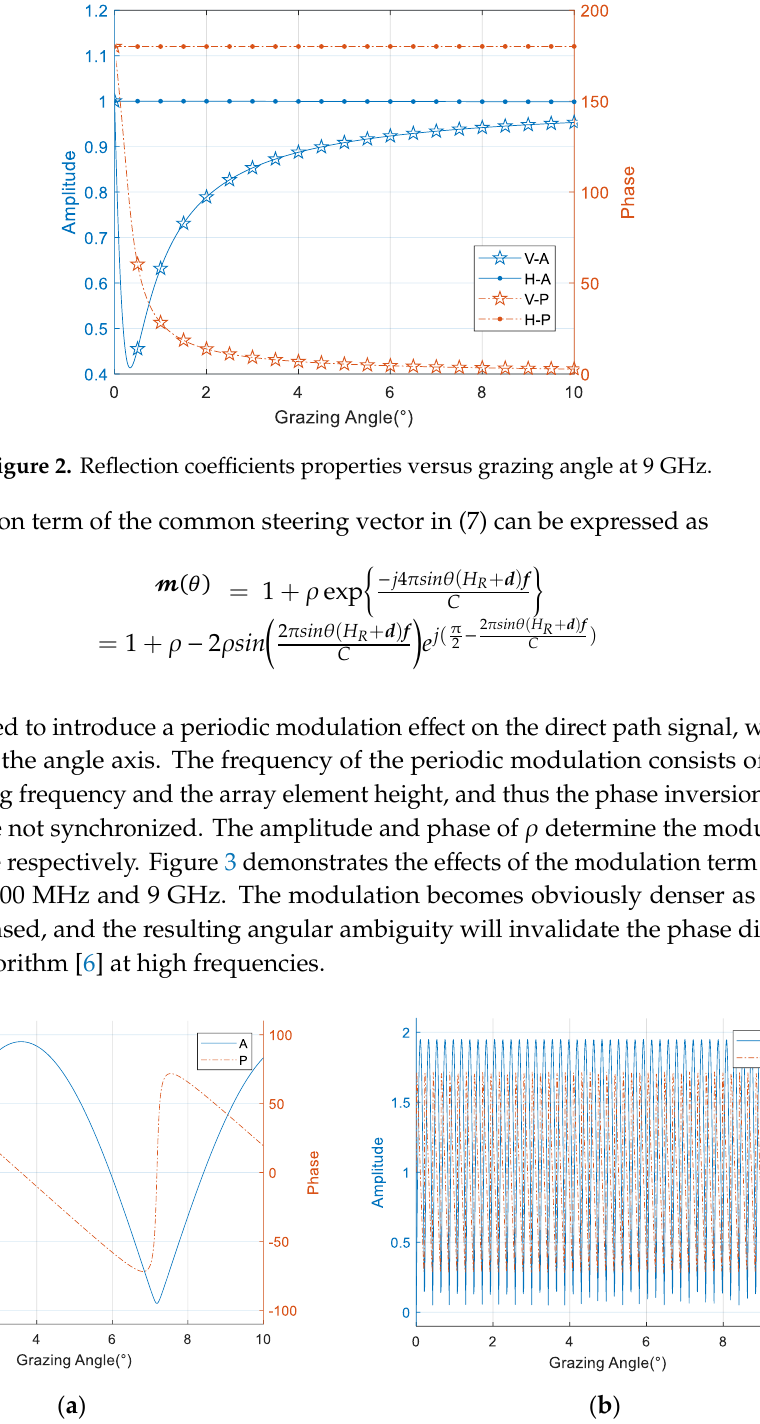
Figure 3. The impact of the modulation term in the different working frequency. ( a ) 300 MHz; ( b ) 9 GHz.